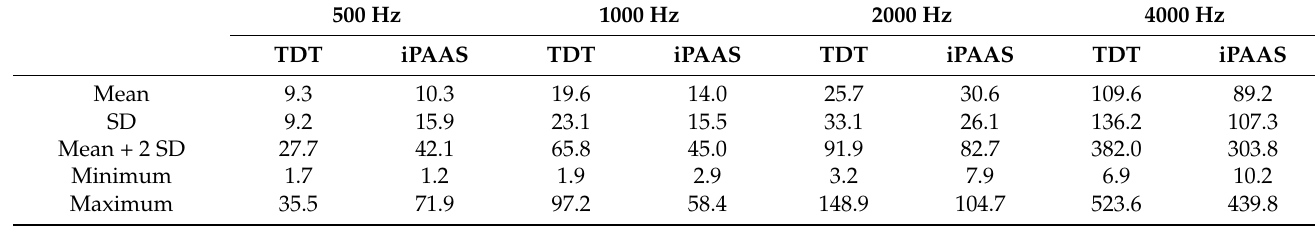
Table 1. Descriptive results for the FD thresholds (given in Hertz) for the laboratory-based system (TDT) and iPAAS system.